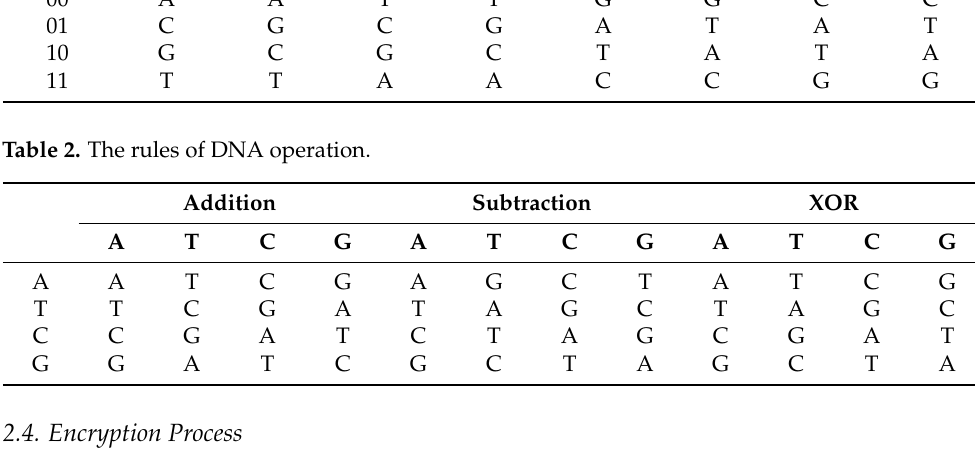
Table 1. The rules of DNA encoding and decoding.